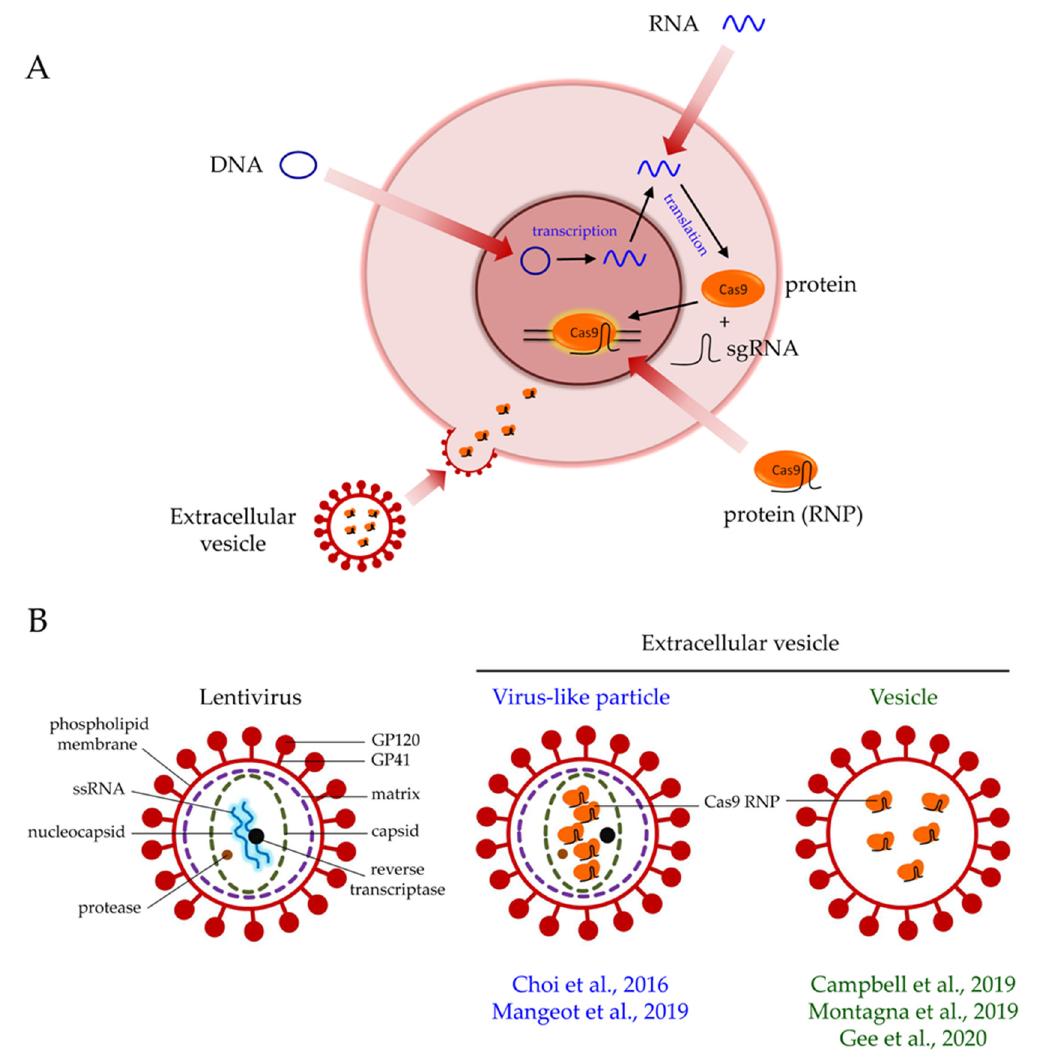
Figure 1. Extracellular vesicle-mediated delivery of Cas9 ribonucleoproteins (RNPs). ( A ) Cas9 can be delivered in the forms of DNA, mRNA, or protein. The protein format enables the immediate action of Cas9 when it is in the nucleus. The transduction of extracellular vesicles releases pre-loaded Cas9 RNPs into cells for efficient gene editing. ( B ) Structural differences between a lentivirus, a virus-like particle, and a vesicle.